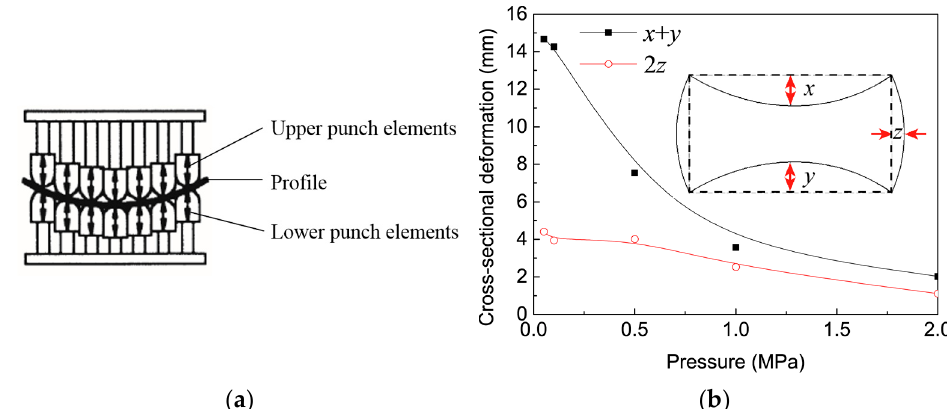
Figure 11. ( a ) Principle of the multi-point bending [50], ( b ) effect of inner pressure on cross-sectional distortion [51].